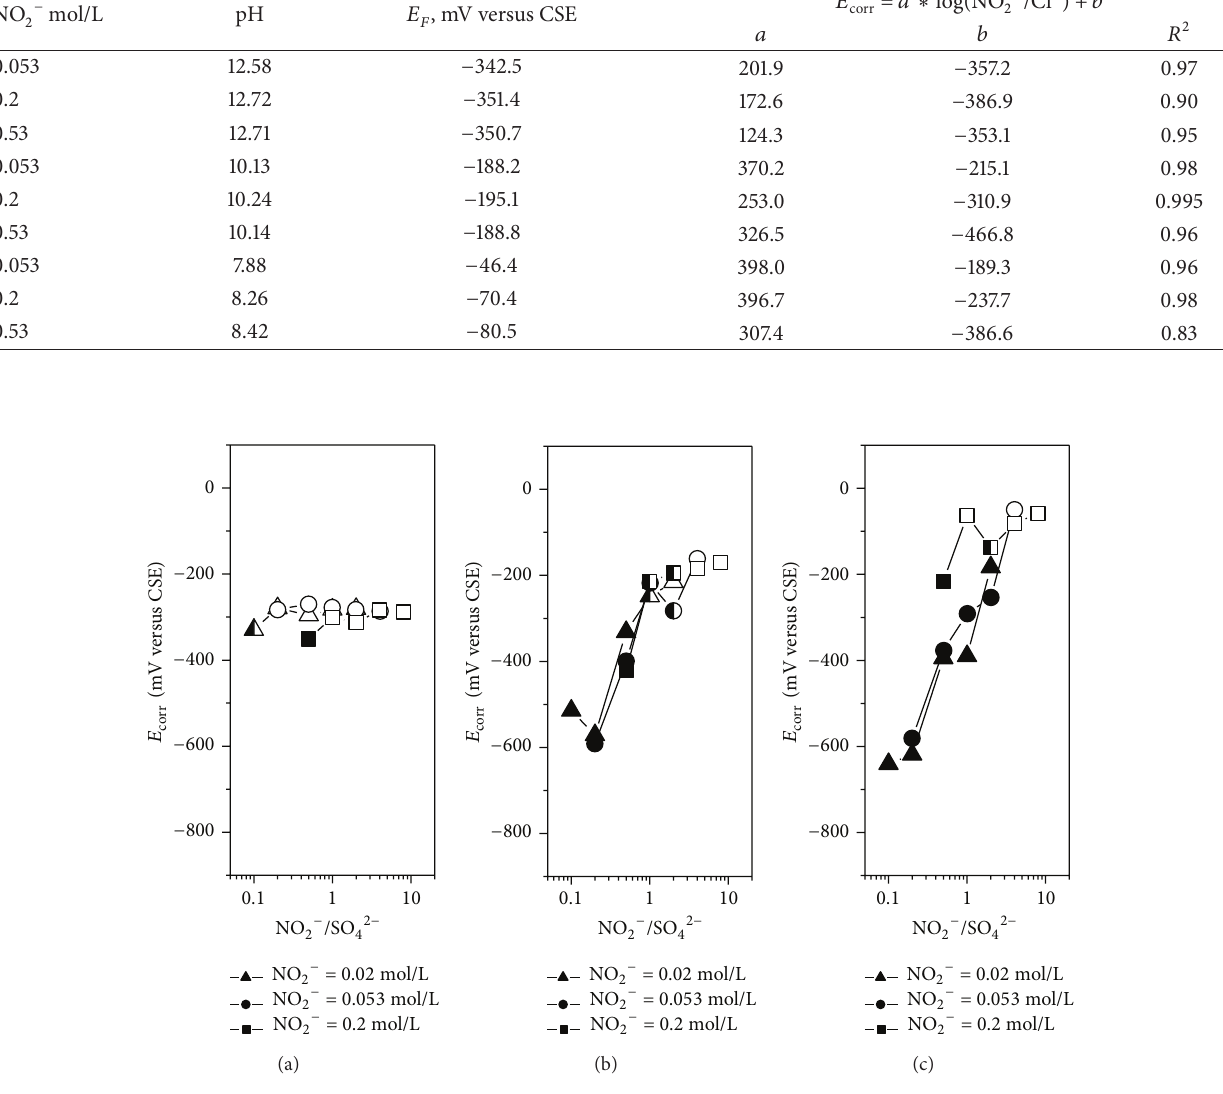
Table 4: Relationship between 𝐸